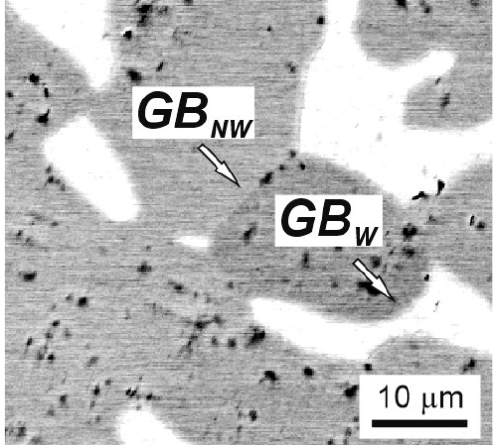
Figure 11. SEM micrograph of the TiZrHfMoCrCo alloy annealed at 1000 °C 336 h, where GB W is the completely wetted grain boundary and GB NW is the partially wetted grain boundary.